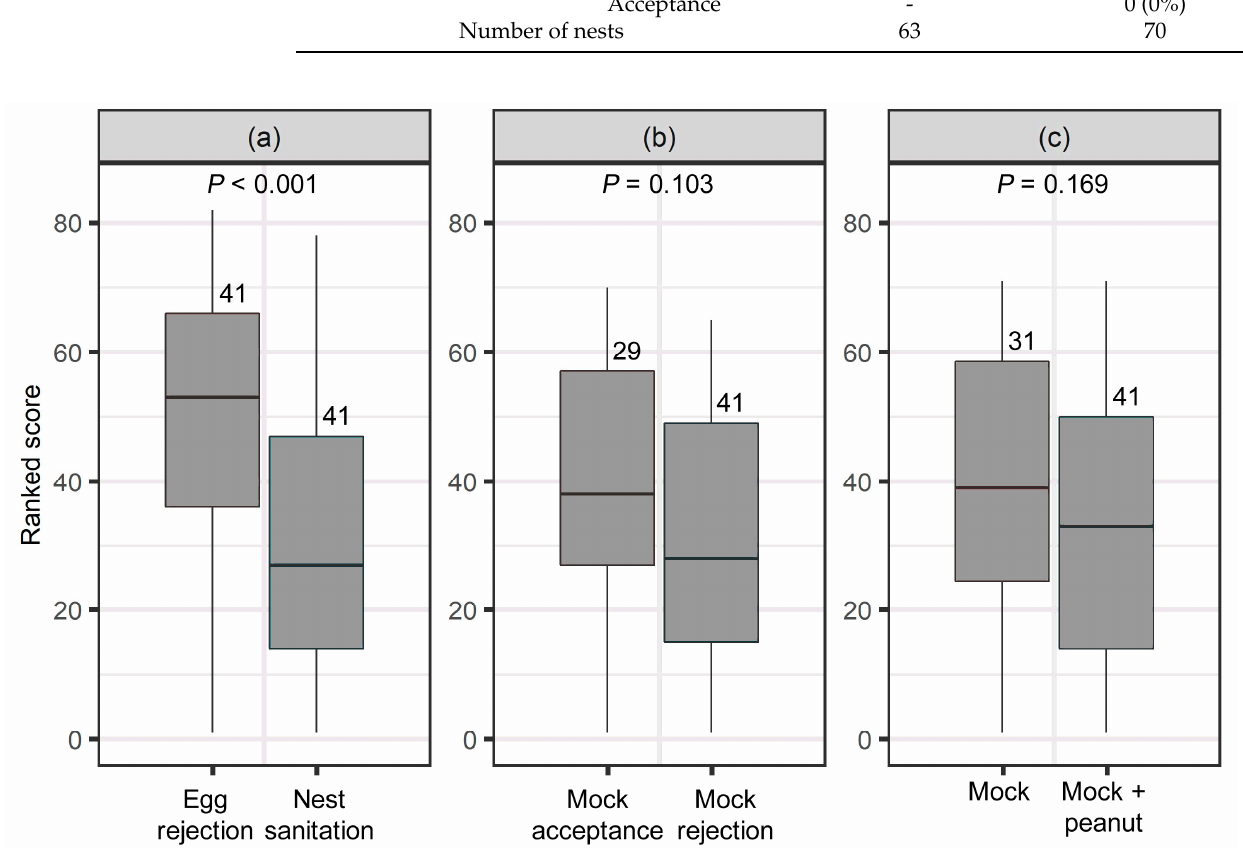
Figure 2. Boxplots (median, quartiles, and range) for the response latency of egg rejection and nest sanitation in barn swallows. ( a ) Comparison of response latency between paired egg rejection and nest sanitation in the mock egg + peanut shell (model + peanut) trial. ( b ) Comparison of nest sanitation latency between mock acceptance and mock rejection subsets in the mock + peanut trial. ( c ) Comparison of egg rejection latency between mock and mock + peanut trials. Numbers above